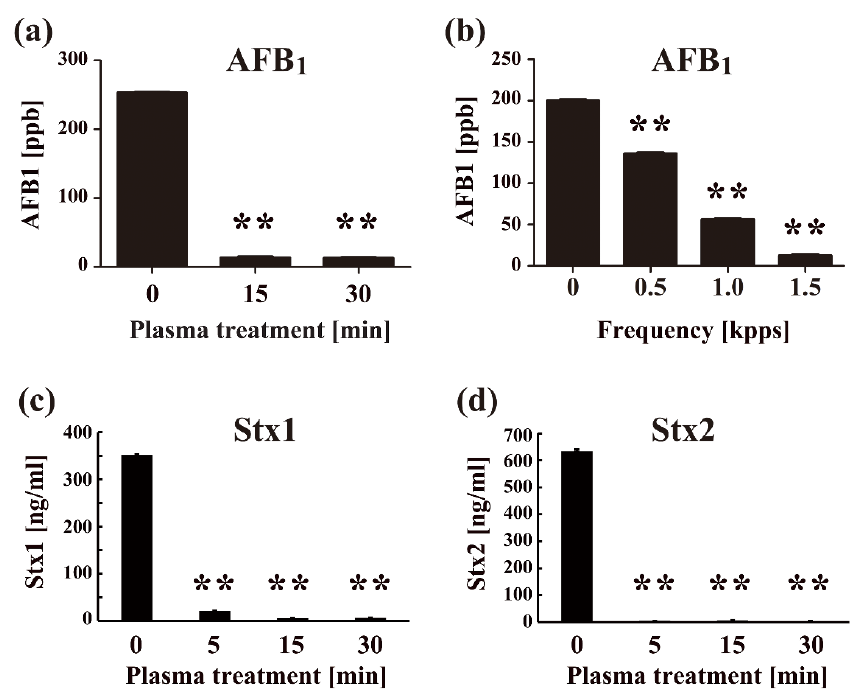
Figure 4. Direct plasma treatment inactivates toxins. Quantitative measurement of aflatoxin B 1 (AFB1) ( a , b ), Shiga toxin 1 (Stx1) ( c ), Shiga toxin 2 (Stx2) (D) after low-pressure nitrogen gas plasma treatment